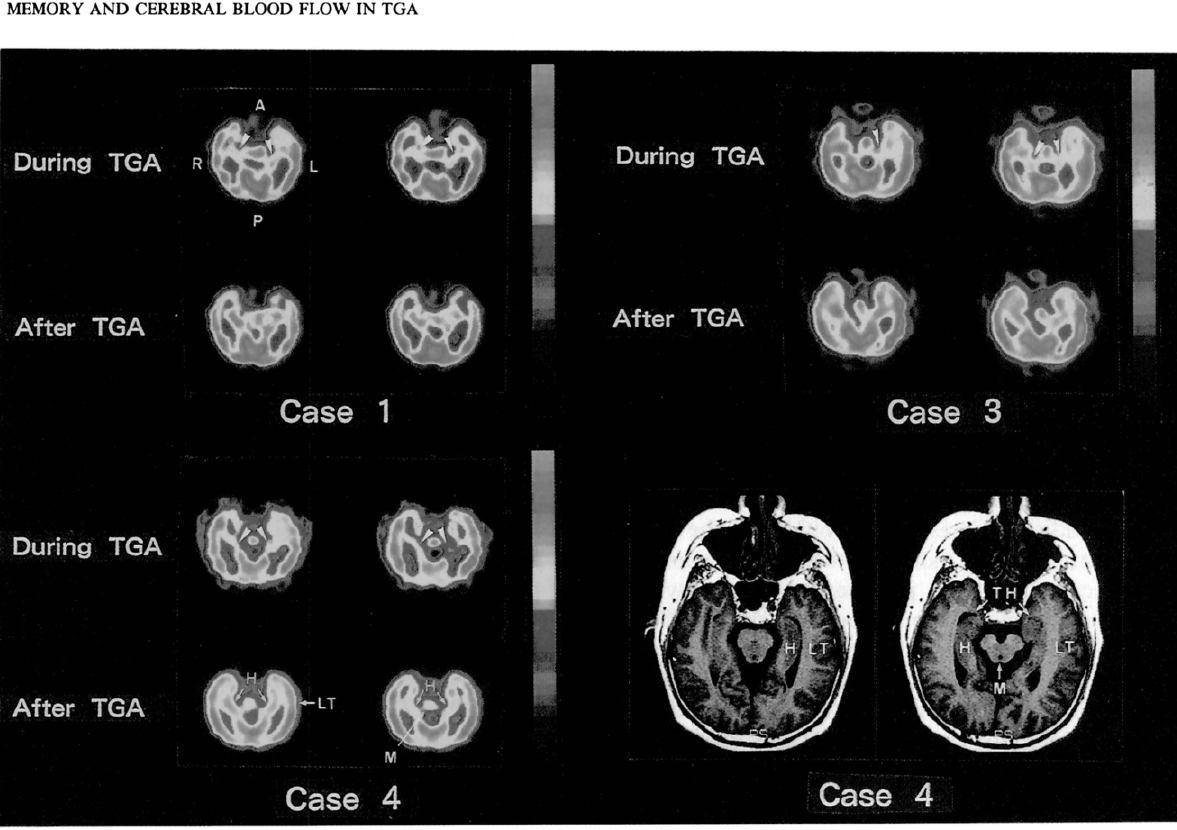
FIG. 4. Hippocampal SPECT images·of Cases 1, 3 and 4. Images in the upper row were taken during TGA and those in the lower row on the first trial after the attack. In each case, the left and right images are images involving the lower and upper hippocampal regions, respectively. Hippocampal MR images of Case 4, approximately corresponding to the level of the hippocampal slices of SPECT of Cases 1, 3 and 4, are shown in the bottom right for anatomical identification of hippocampal SPECT images. In the SPECT and MR images, the left side of the slices corresponds to the right side of the brain. Pink corresponds to the highest level of cerebral blood flow and blue the lower level. White arrowheads indicate areas with reduced blood flow. Compared with after-TGA images, the images taken during TGA demonstrate a definite hypoperfusion in the medial portion of the temporal lobe bilaterally in Cases 1, 3 and 4. Blood flow in other areas including the frontal cortex and thalamus was preserved. A, anterior; P, posterior; R, right; L, left; H, hippocampus; TH, temporal horn; L T, lateral aspect of the temporal lobe; M,